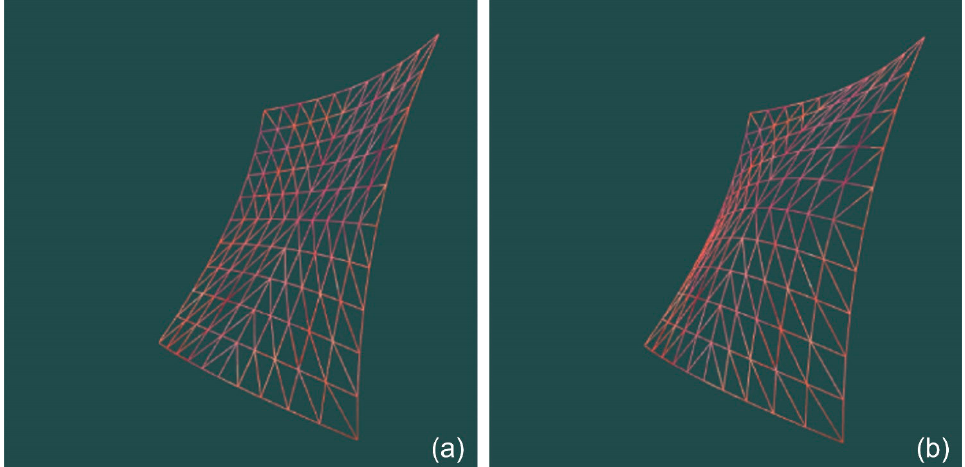
Figure 13. Comparison of models before and after modeling under an external force: ( a ) initial state and ( b ) stable state after stress.